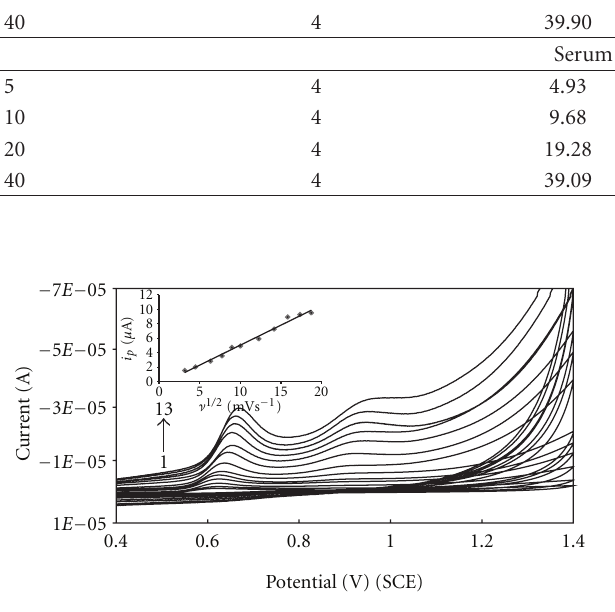
Figure 4: Cyclic voltammograms of 1.25 × 10 − 4 M MMF in phosphate bu ff er of pH 6.0 on GCE at di ff erent scan rates: (1) 10, (2) 20, (3) 40, (4) 60, (5) 80, (6) 100, (7) 200, (8) 300, (9) 400, (10) 500, (11) 600, (12) 700, and (13) 800mVs − 1 . Insert: peak current versus square root of scan rate in the scan rate range 10–350 mVs − 1